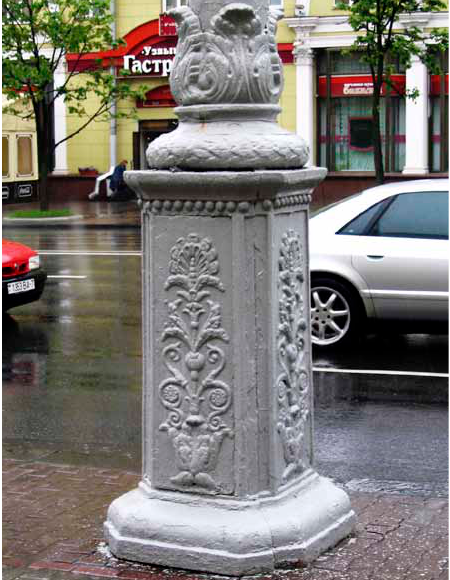
fig. 23. Cotton and geometric motives in the socialist realism architecture of ashgabat. r. Čepaitienė